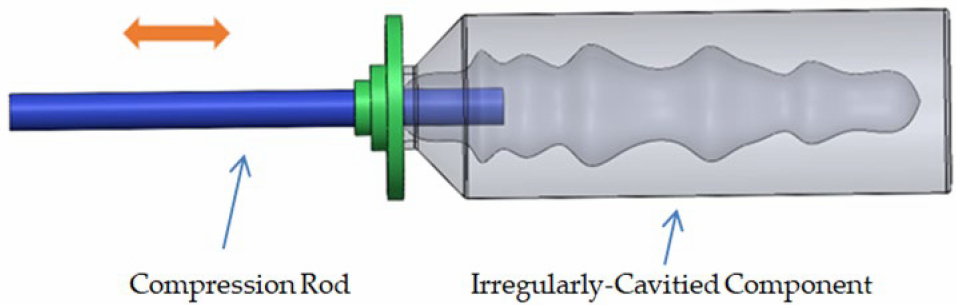
Figure 1. Schematic diagram of the volume-measurement method using micro-compressed